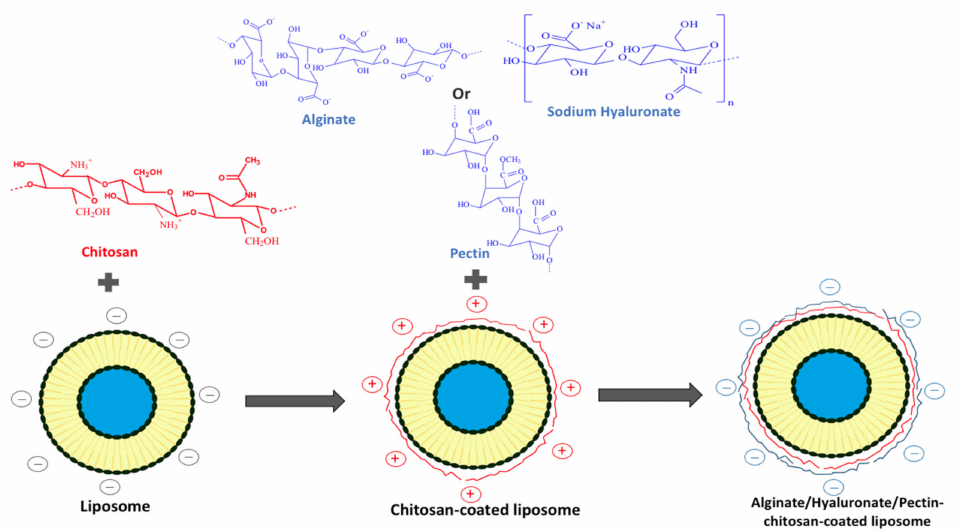
Figure 5. Preparation of polyelectrolyte delivery system layer-by-layer self-assembly of chitosan and alginate/hyaluronate/pectin onto the